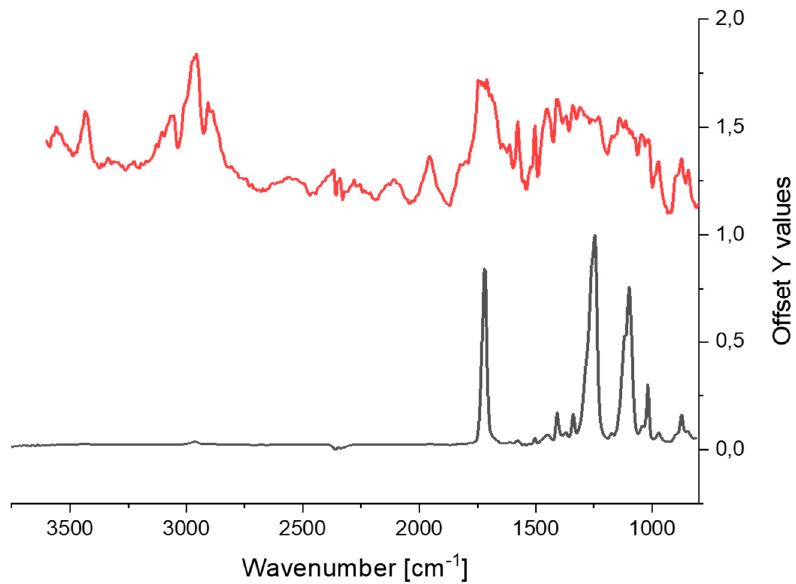
Figure 8. Normalized FTIR spectra of reference PET particles. Top (red line): measured in reflectance mode on FTIR microscope; Bottom (black line): measured in ATR mode.